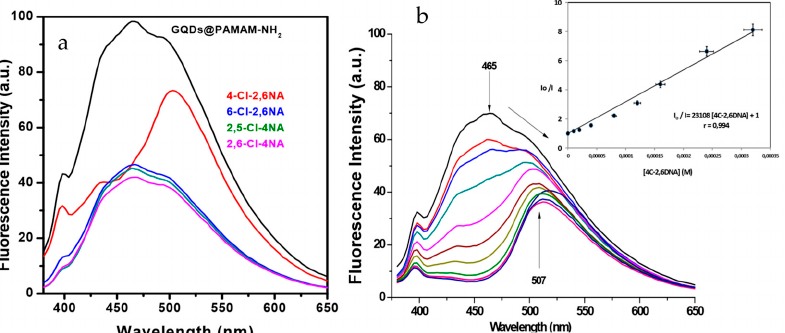
Figure 20. ( a ) Fluorescence quenching of PAMAM-NH 2 -capped C-dots in the presence of 4-Cl-2,6-DNA and related compounds (8 × 10 − 5 M); ( b ) fluorescence spectra of PAMAM-NH 2 -capped C-dots with various concentrations of 4-Cl-2,6-DNA: (i) 0 M, (ii) 1 × 10 − 5 M, (iii) 2 × 10 − 5 M, (iv) 4 × 10 − 5 M, (v) 8 × 10 − 5 M, (vi) 1.2 × 10 − 4 M, (vii) 1.6 × 10 − 4 M, (viii) 2.4 × 10 − 4 M, (ix) 3.2 × 10 − 4 M and ( × ) 6 × 10 − 4 M, with inset Stern–Volmer plot. Reproduced with permission from reference [83], Carbon; published by Elsevier Ltd.,